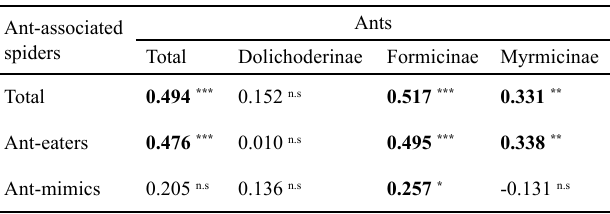
Table 1. Spearman correlation coefficients (Rho) between abundance of ants (total and subfamily groups) and abundance of ant-associated spiders (total, ant-eaters and ant-mimics).